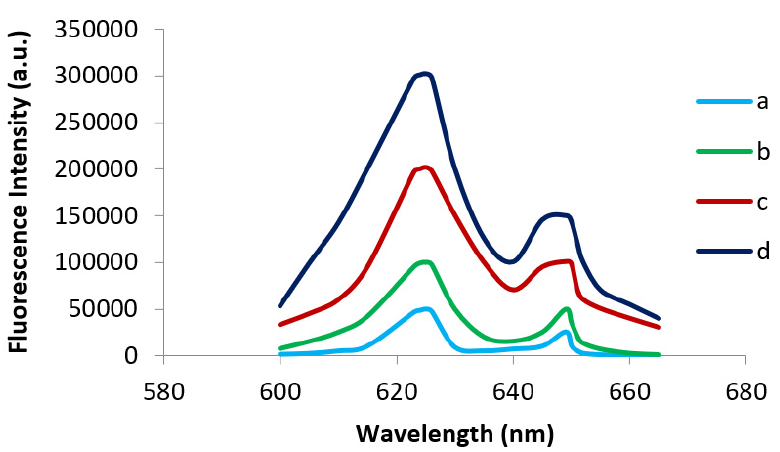
Figure 5. Overlay of emission spectra of four samples of Southern flying squirrel hair (a–d). λ em = λ em = 625 nm and λ ex = 365 625 nm and λ ex = 365 nm.